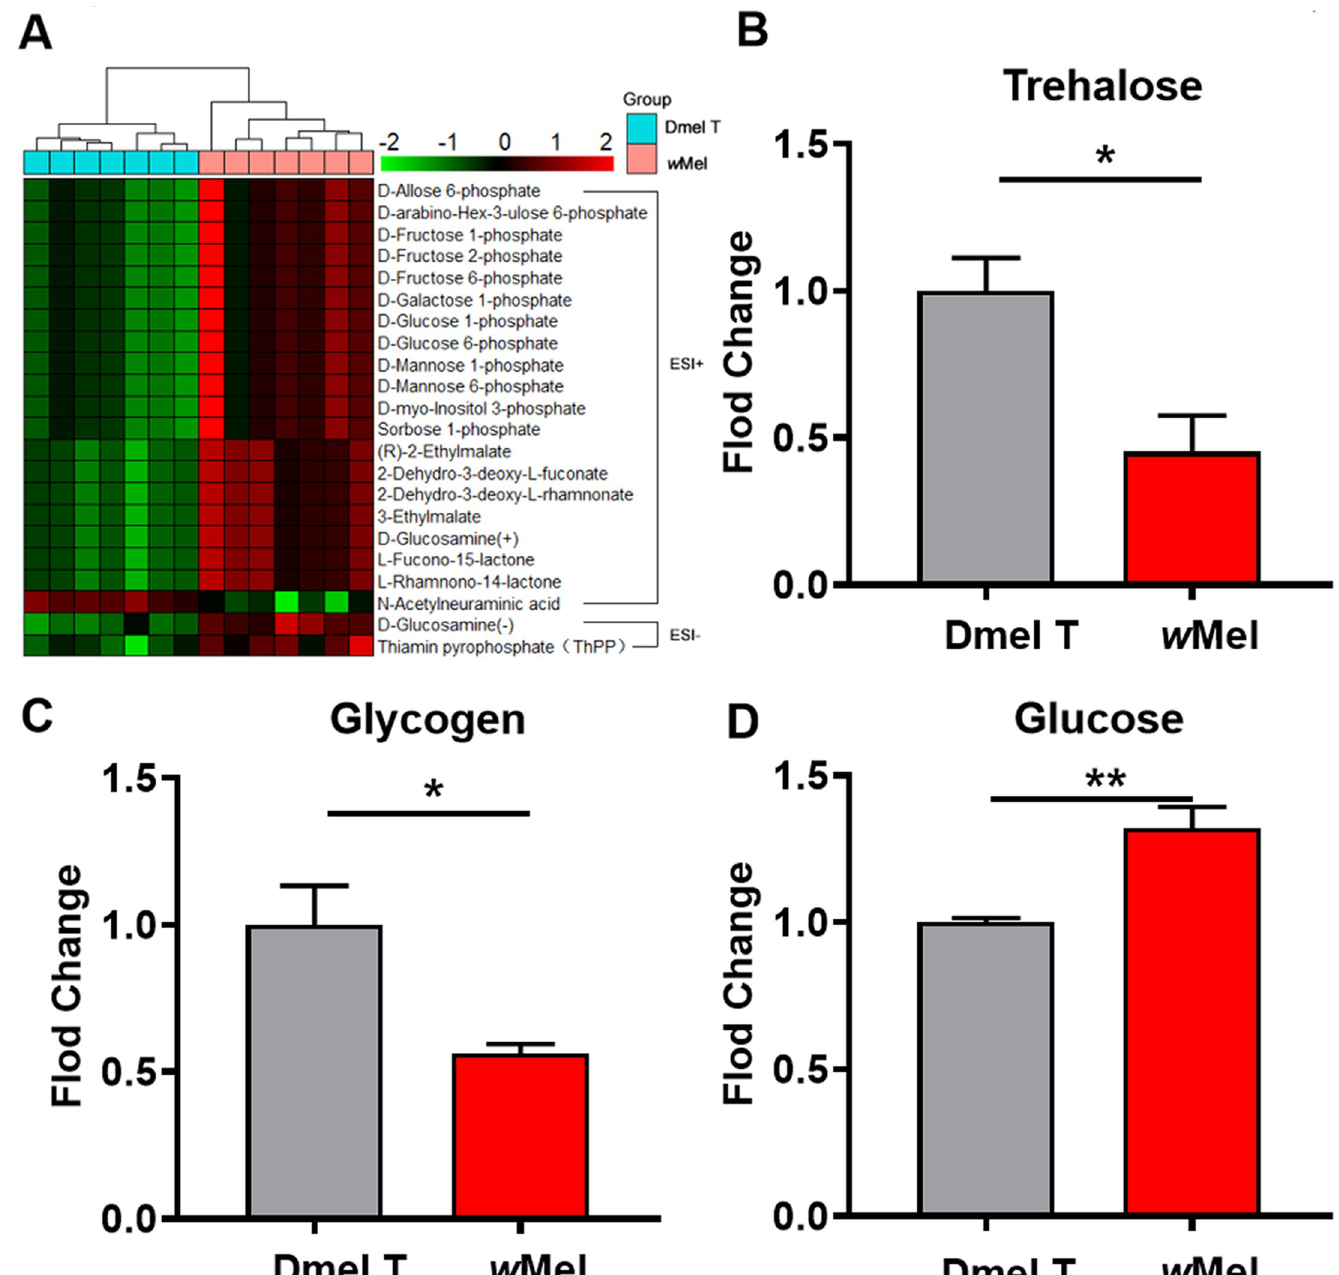
Fig 3. Wolbachia infection affected the carbohydrate metabolism of D . melanogaster . (A) Cluster analysis of differential metabolites related to carbohydrate metabolism. Corresponding measurements of trehalose (B), glycogen (C), glucose (D), in 1d male flies. Dmel T: uninfected flies; w Mel: Wolbachia -infected